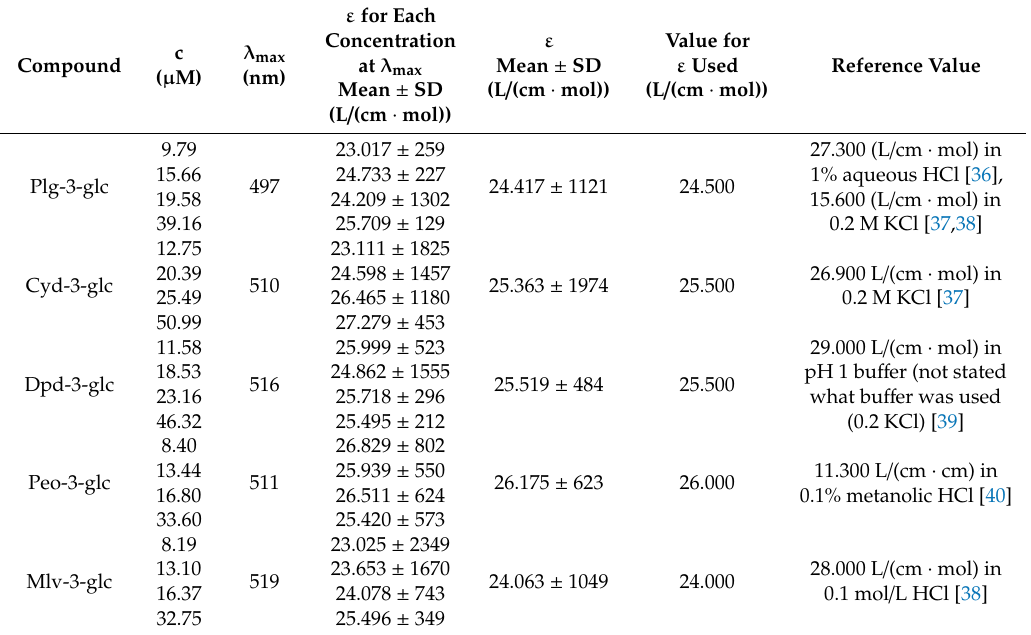
Table A1. Determination of the absorption coefficients ε for the anthocyanin-3-glycosides (reference compounds).